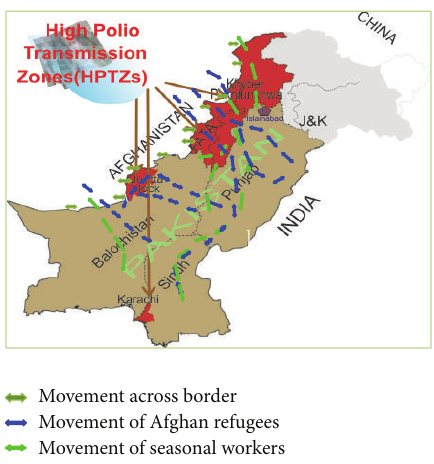
Figure 1: Map of Pakistan showing HPTZ (adopted and modified from [23,